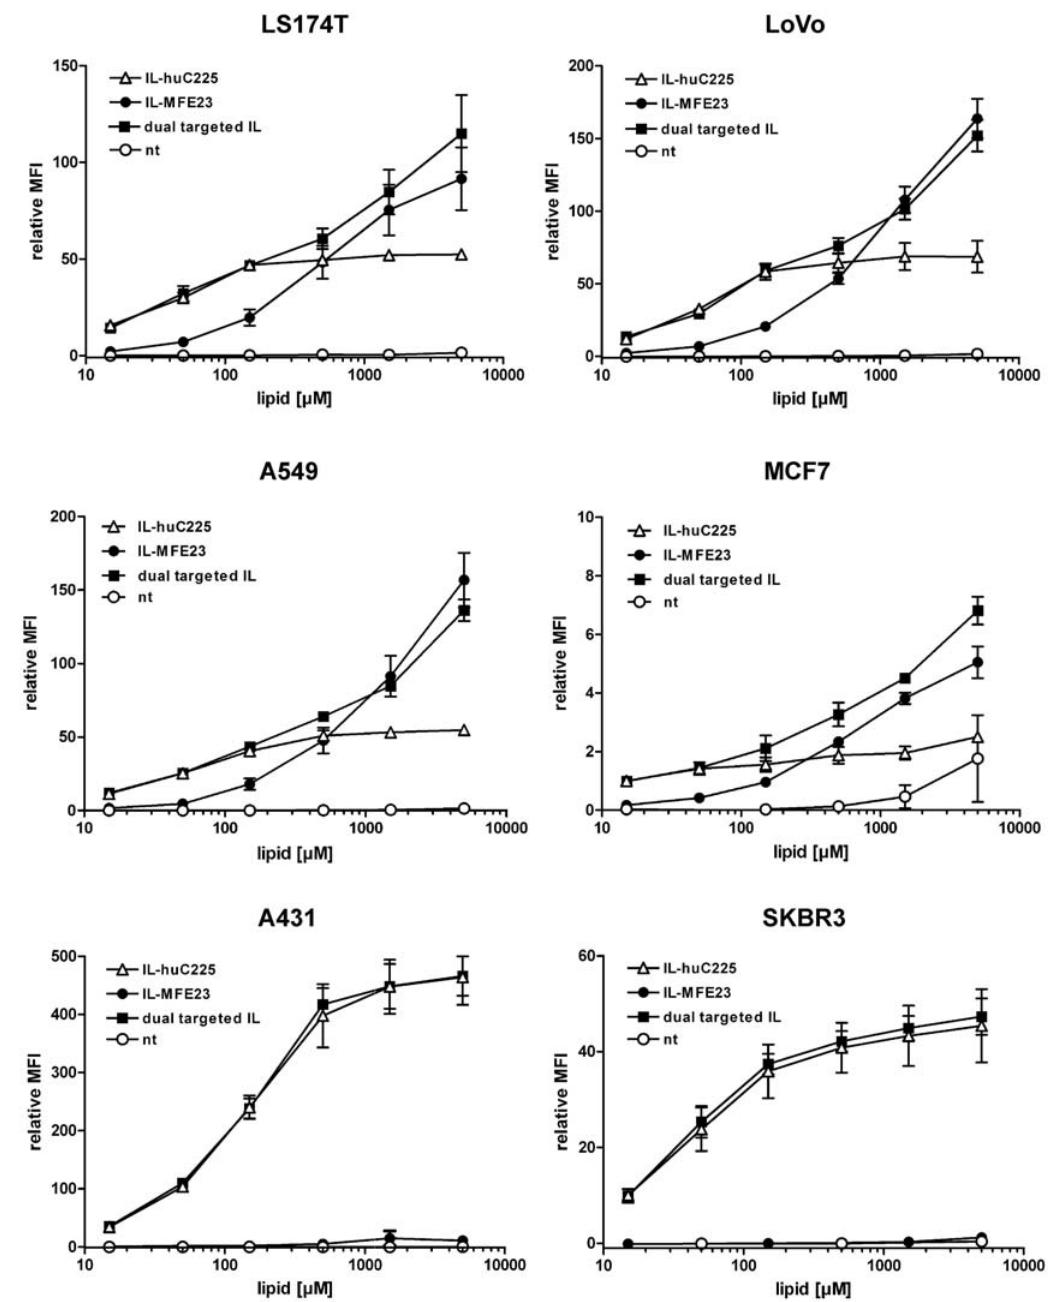
Figure 7. Flow cytometry analysis of binding of monospecific (hu225-IL, MFE23-IL) and dual-targeted immunoliposomes (dt-IL) to various tumor cell lines (n = 3). Non-targeted (nt) liposomes were included as negative